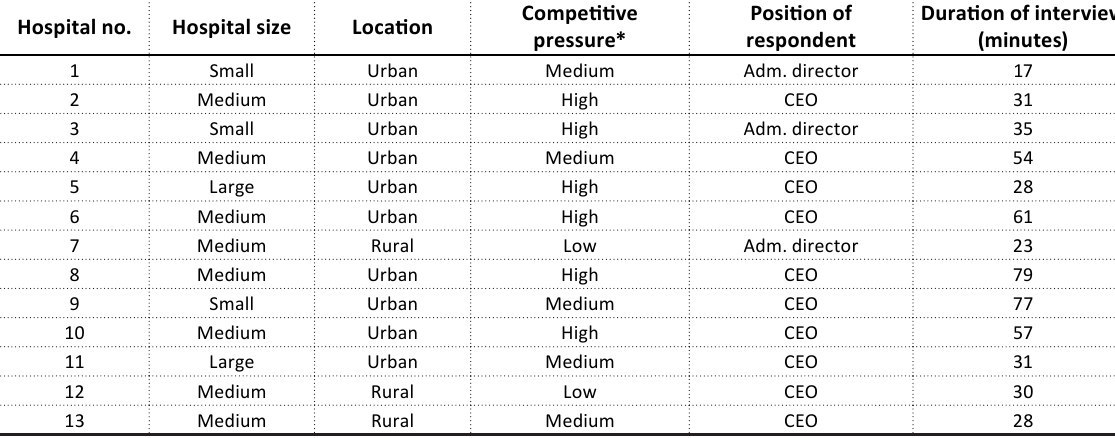
Table 1. Description of sample Hospital